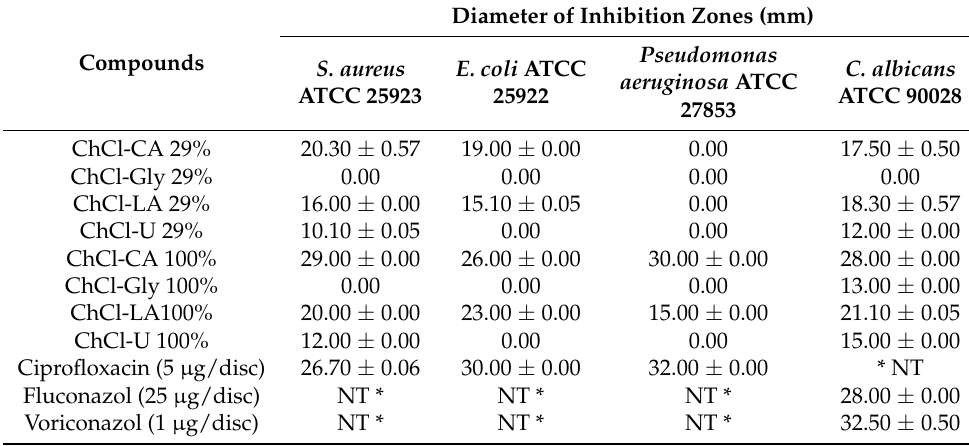
Table 6. Antibacterial and Antifungal Activities of the Tested Compounds. Diameter of Inhibition Zones (mm) Compounds